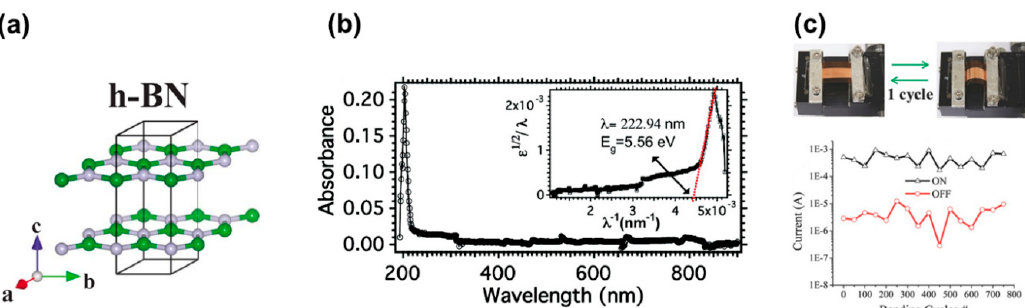
Figure 5. ( a ) Schematic of a hexagonal boron nitride (h-BN) showing an optimized atomic structure with two-dimensional h-BN atomic layers. Reprinted with permission from ref. [84]. Copyright (2019) American Physical Society. ( b ) The UV − visible absorption spectra of the h-BN film showing 99% light transmission in the wavelength range from 250 to 900 nm. Reprinted with permission from ref. [85]. Copyright (2010) American Chemical Society. ( c ) Image of bending test and results of bending experiment of the h-BN-based resistive memory device. Reprinted with permission from ref. [92]. Copyright (2016) John Wiley & Sons.